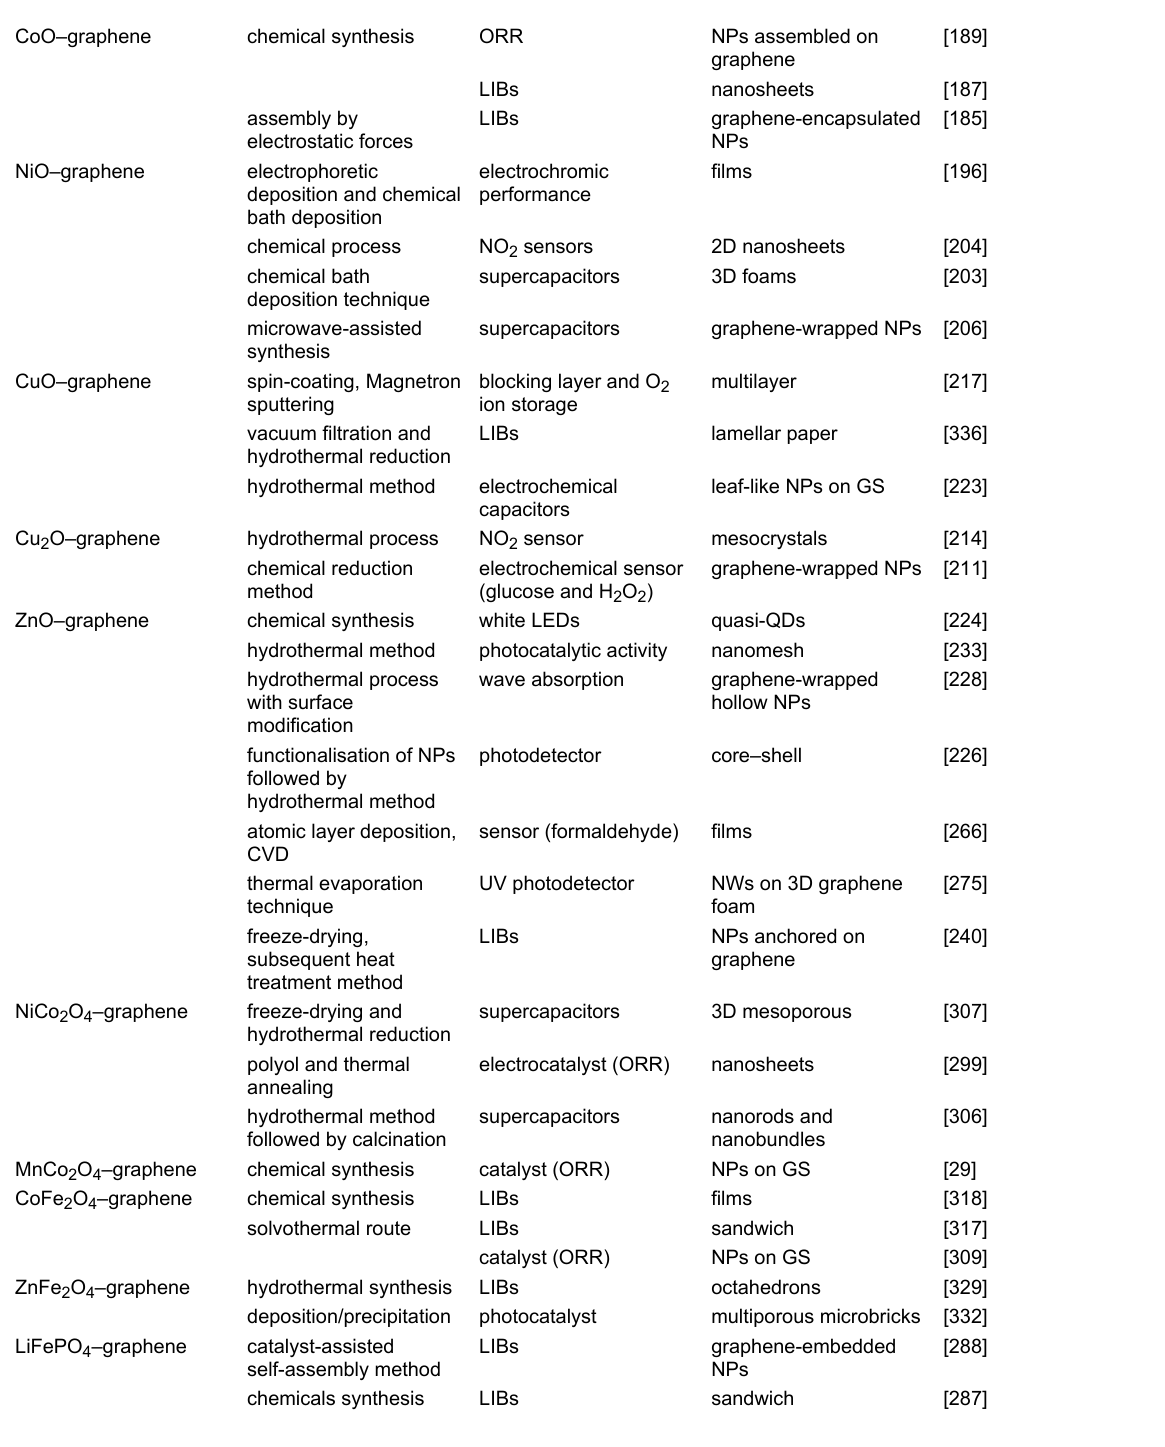
Table 1: Important hybrid material synthesis procedures and their potential applications. (continued)